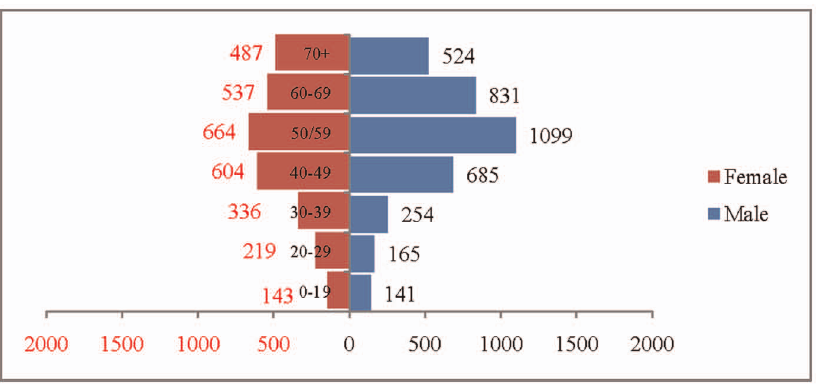
Figure 7. Estimated number of hospitalisation due to CVDs (in 000’s) by age and sex, India, 2004.